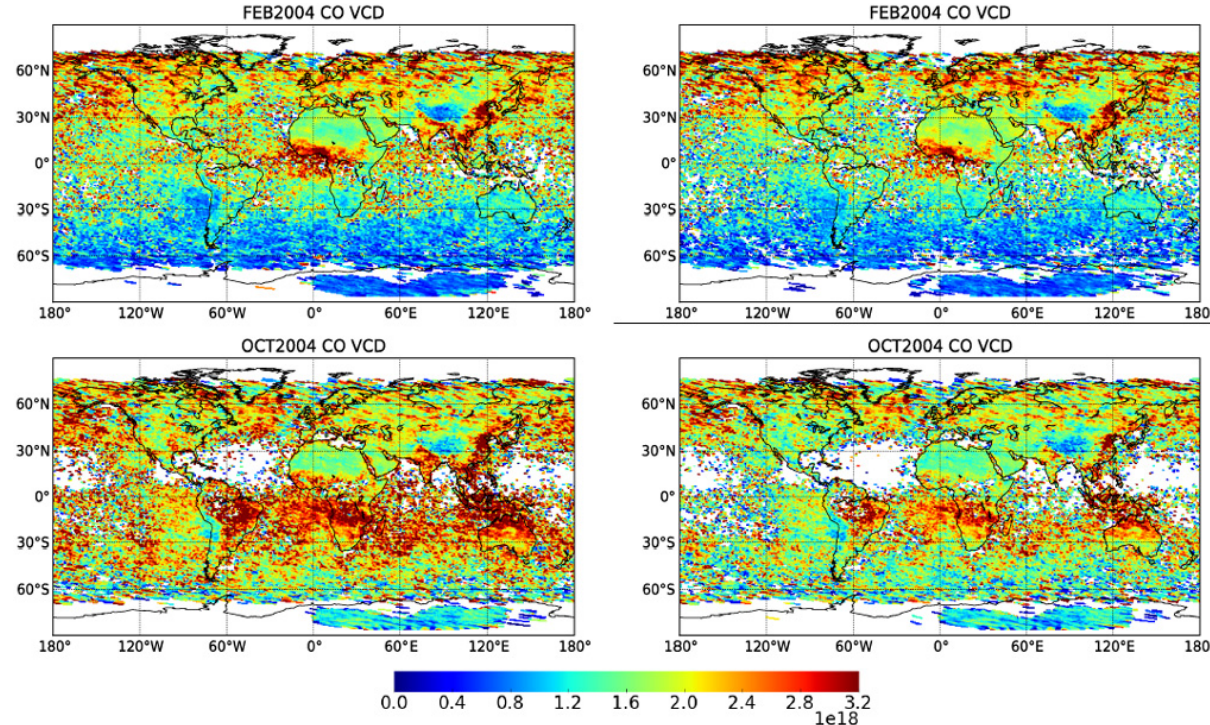
Fig. 4. Comparison of a retrieval using a constant mask flagging only pixels that are marked as “bad” for at least half of the cases of the year 2004 (left) and a retrieval using a dynamic mask appropriate for each measurement (right). In February (top) the results look similar while the result for October (bottom) is noisier for the constant mask that does not flag all bad pixels. CO VCD in units moleccm − 2